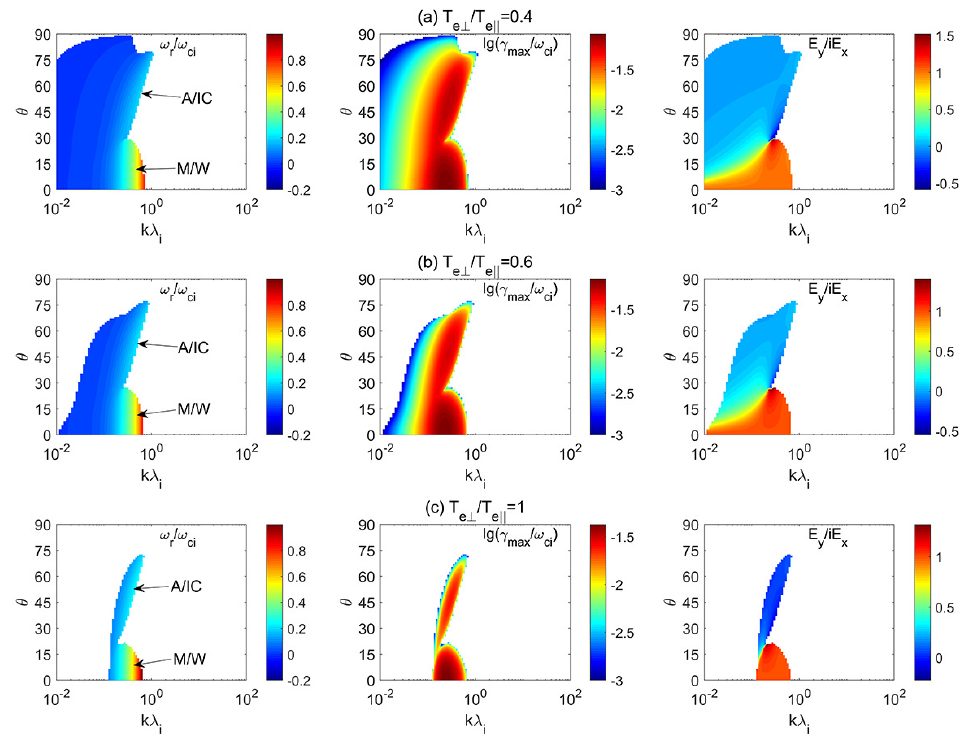
Figure 3. Color bar distributions of the real frequency ( ω r / ω ci ), maximum growth rate ( γ max / ω ci ), and polarization ( E y / iE x ) in the plane of the normalized wavelength ( k λ i ) and propagation angle ( θ ) for various electron temperature anisotropies: ( a ) T e ⊥ / T e (cid:107) = 0.4, ( b ) 0.6, and ( c ) 1 in a plasma with high beta β e (cid:107) = 2. The alpha beam drift velocity v α / v A = 2 was